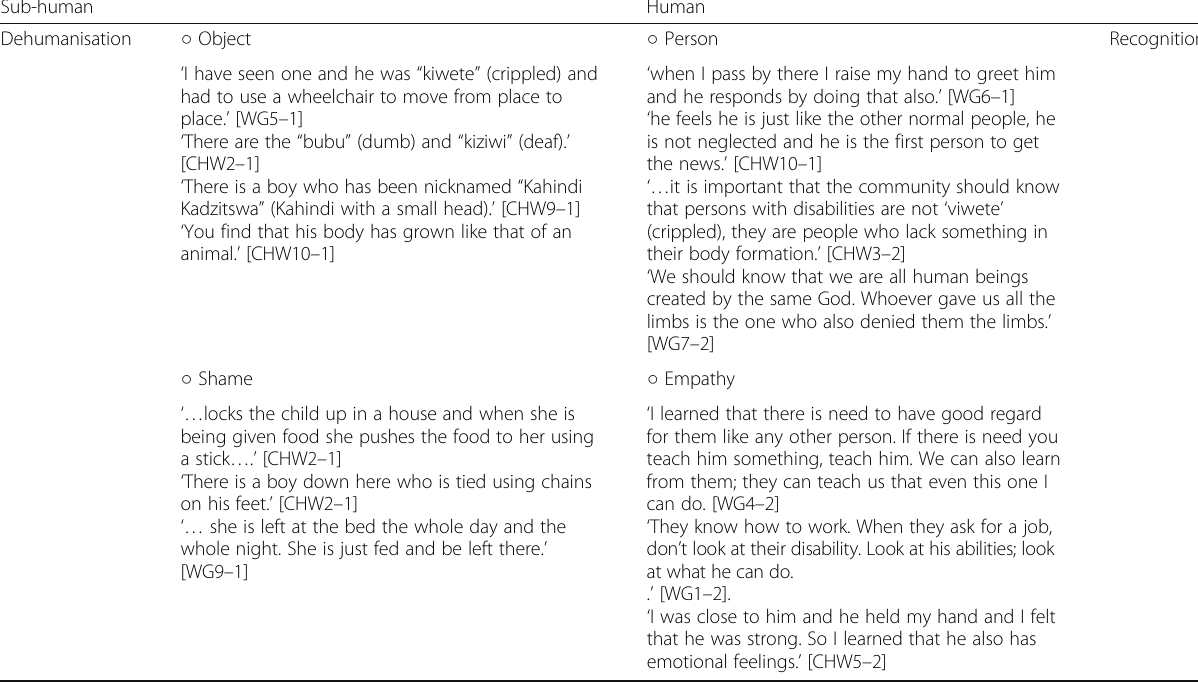
Table 4 Sub-human vs Human construct: Dehumanisation-Recognition Sub-human Human Dehumanisation ○ Object ○ Person